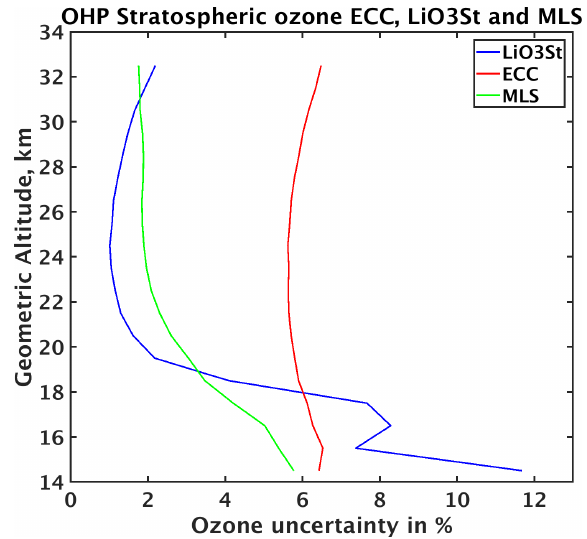
Figure 7. Vertical profiles of the median of the relative ozone con- centration overall uncertainty in the stratosphere for the homoge- nized ECC (red), LiO3St (blue) and MLS